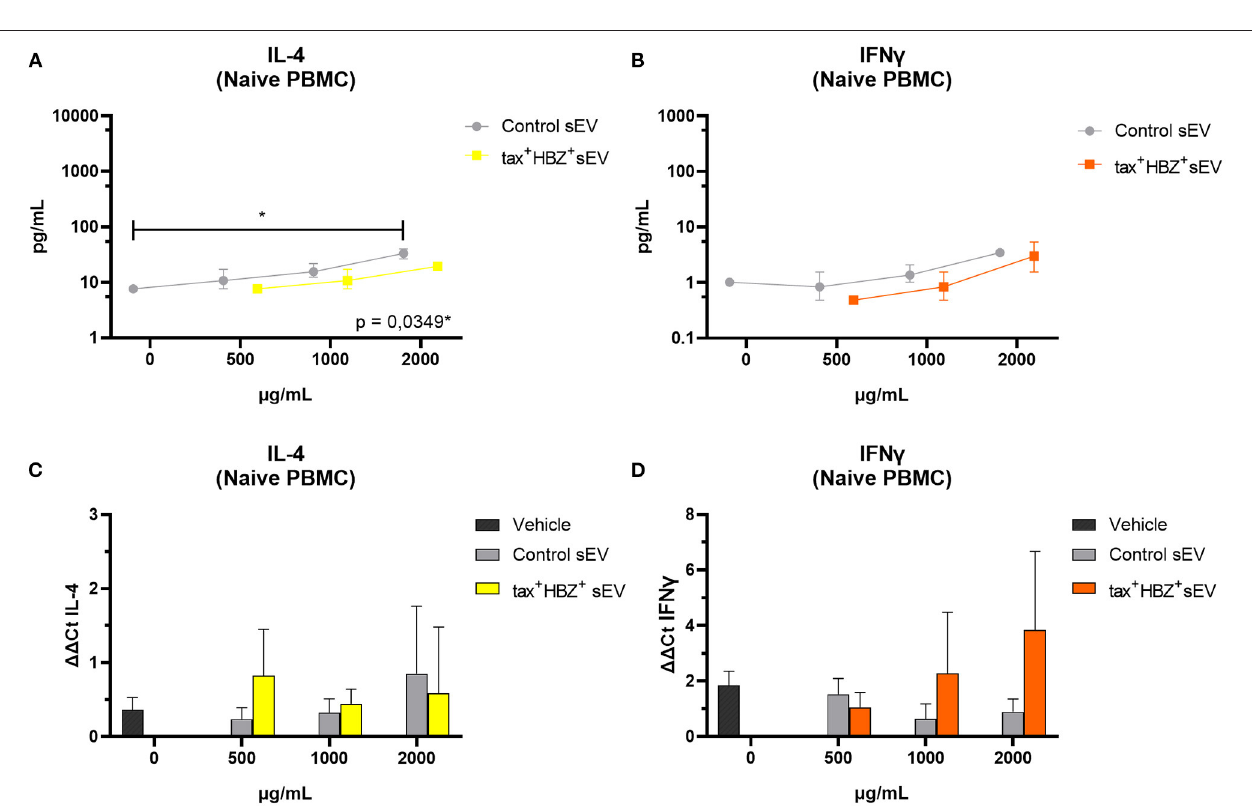
FIGURE 3 | Correlation between HTLV-1 PVL and viral gene expression in sEVs. The HTLV-1 PVL was positively correlated to (A) tax and (B) HBZ transcripts in sEVs. * p < 0.05.